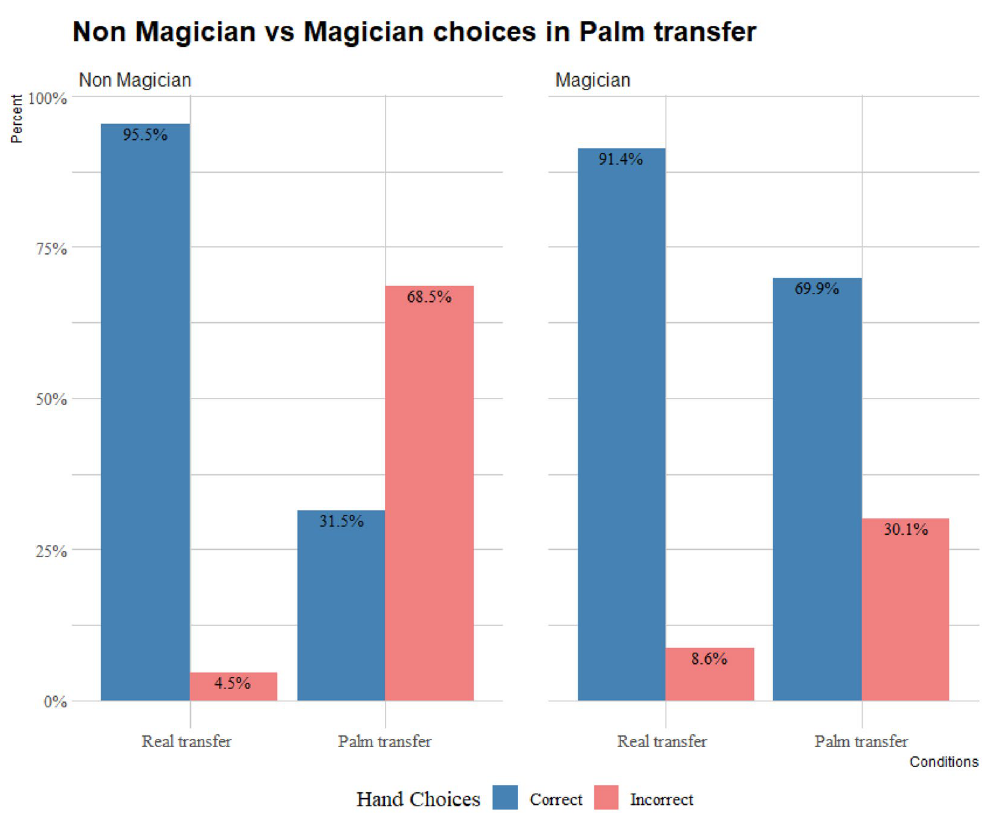
Figure 2. Choices of non-magicians and magicians in palm transfer and real transfer